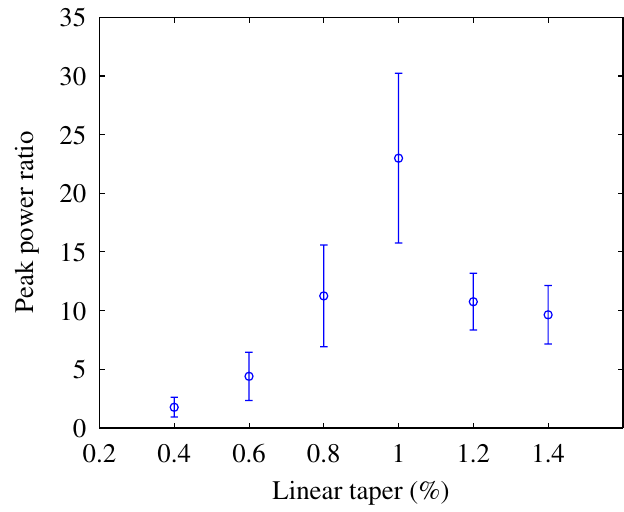
FIG. 6. (Color) The peak power ratio between the central spike and the first side one at a different undulator taper. It is a linear taper over 55 m starting at 15 m. Each point is averaged over five shot noise realizations.